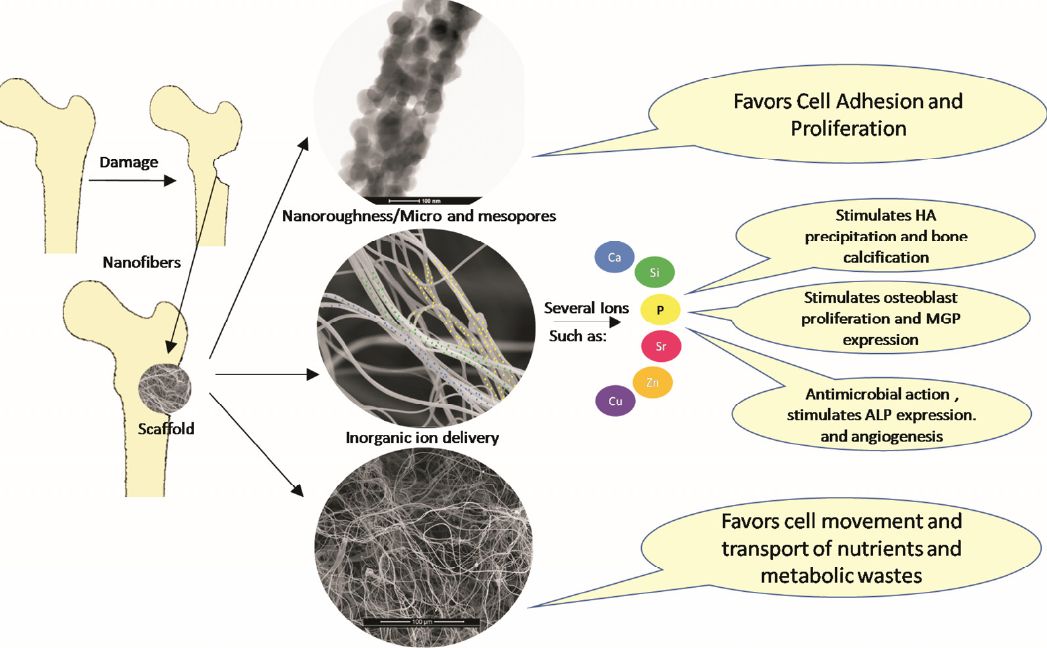
Figure 11. Schematic representation of the influence of ceramic nanofibers on the wound-healing process.